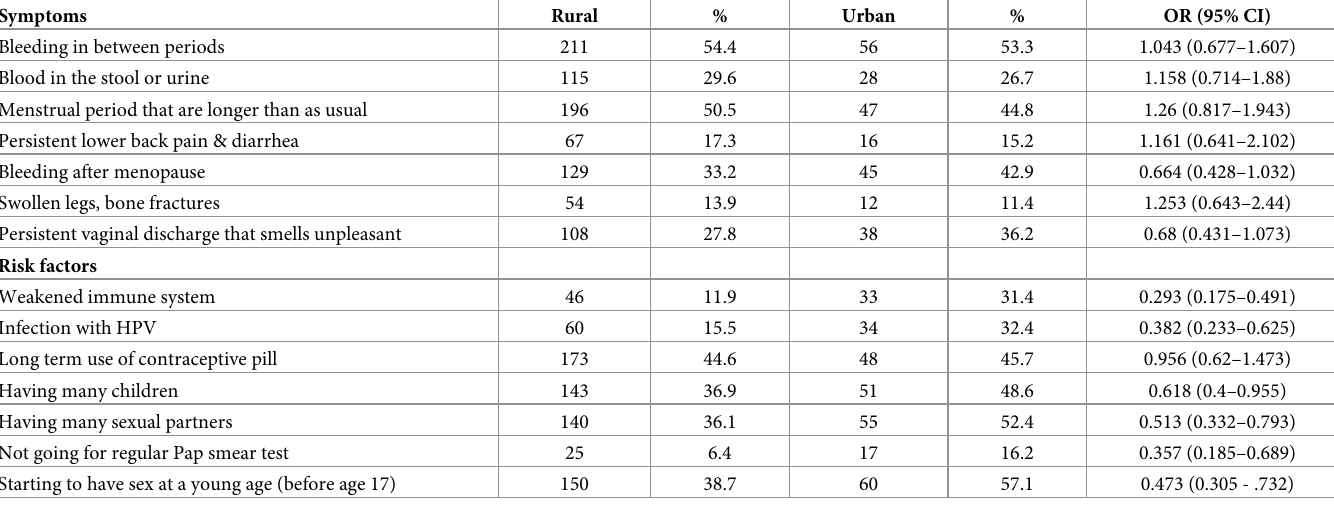
Table 3. Knowledge about symptoms and risk factors of cervical